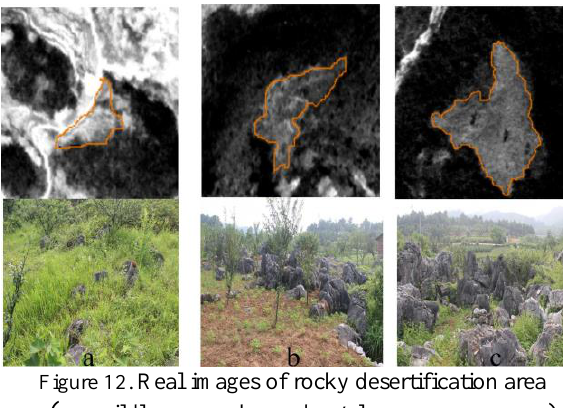
Figure 12. Real images of rocky desertification area (a. mildly severe, b. moderately severe, c. severe)